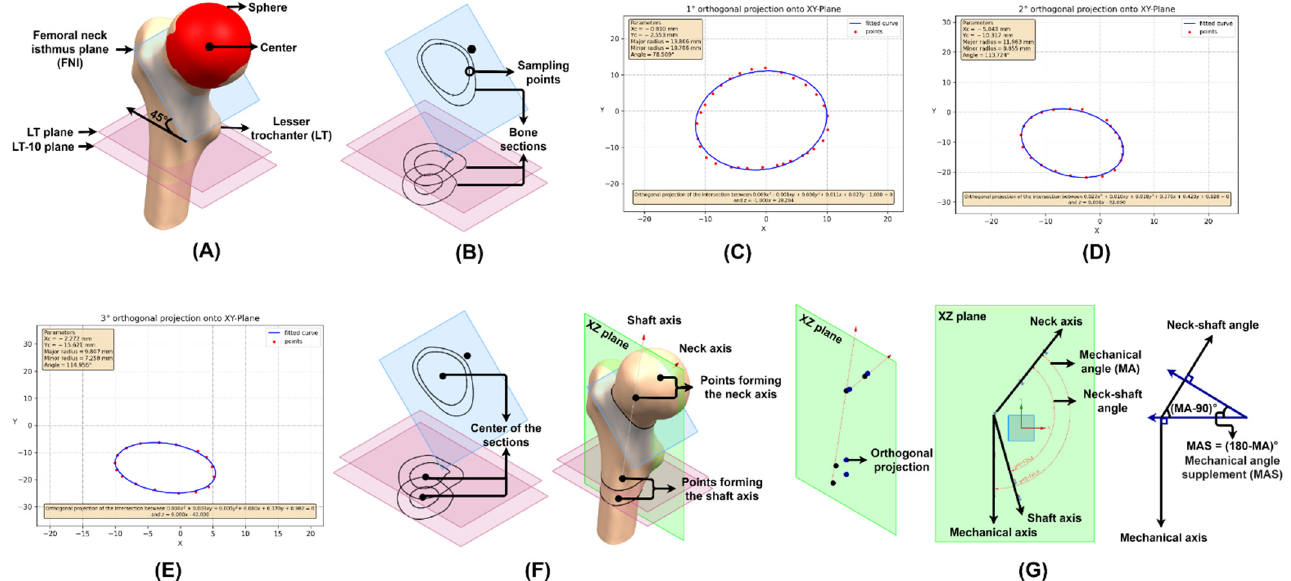
Figure 3. Steps to measure the neck–shaft and mechanical angle. ( A ) Estimation of the femoral head with a sphere and location of the FNI, LT and LT-10 planes. ( B ) Sampling of bone sections. The adjustment made by the app for sections ( C ) FNI, ( D ) LT and ( E ) LT-10. ( F ) Neck and shaft axis. ( G ) Neck–shaft and mechanical angle.